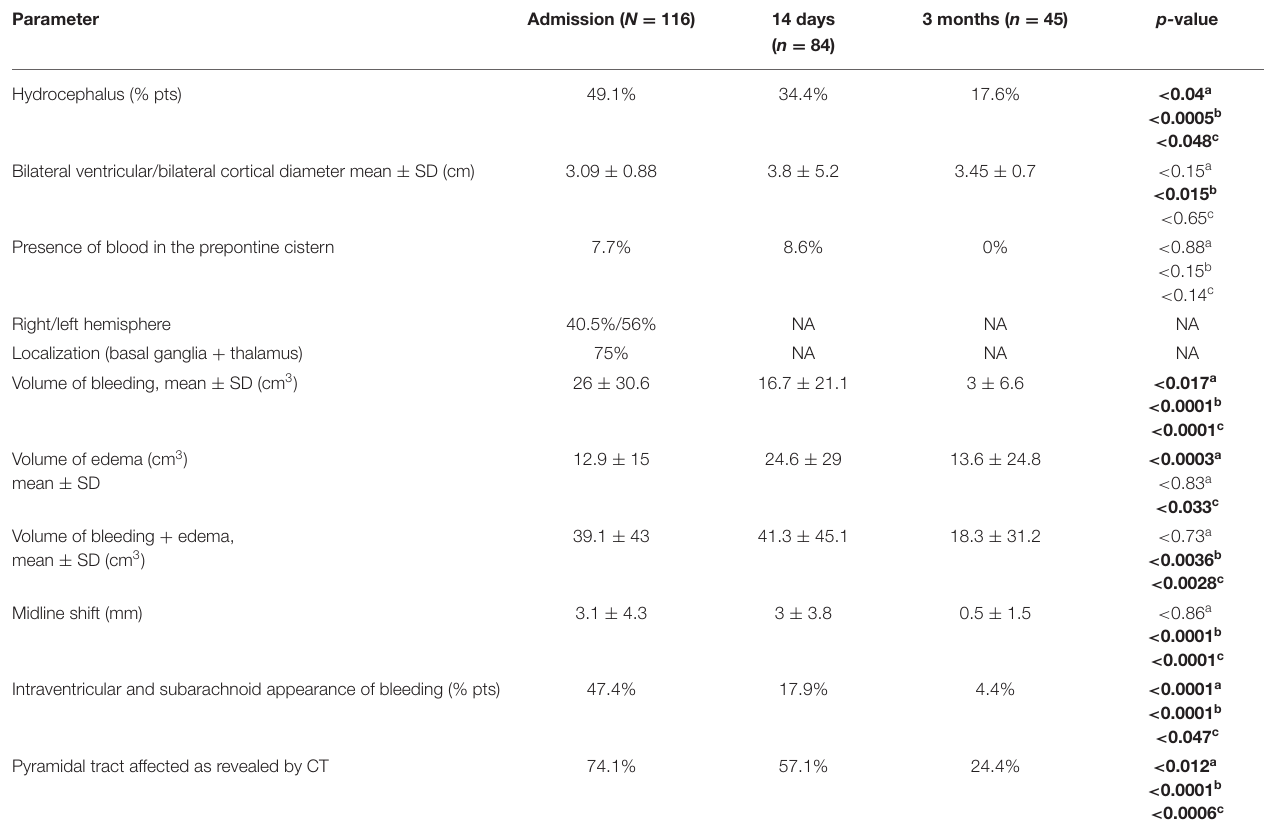
TABLE 3 | Summary of CT parameters on admission, 14 days and at 3 months.